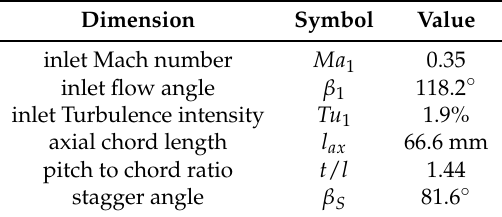
Table 1. Geometry and operating conditions of the TEC-C cascade.